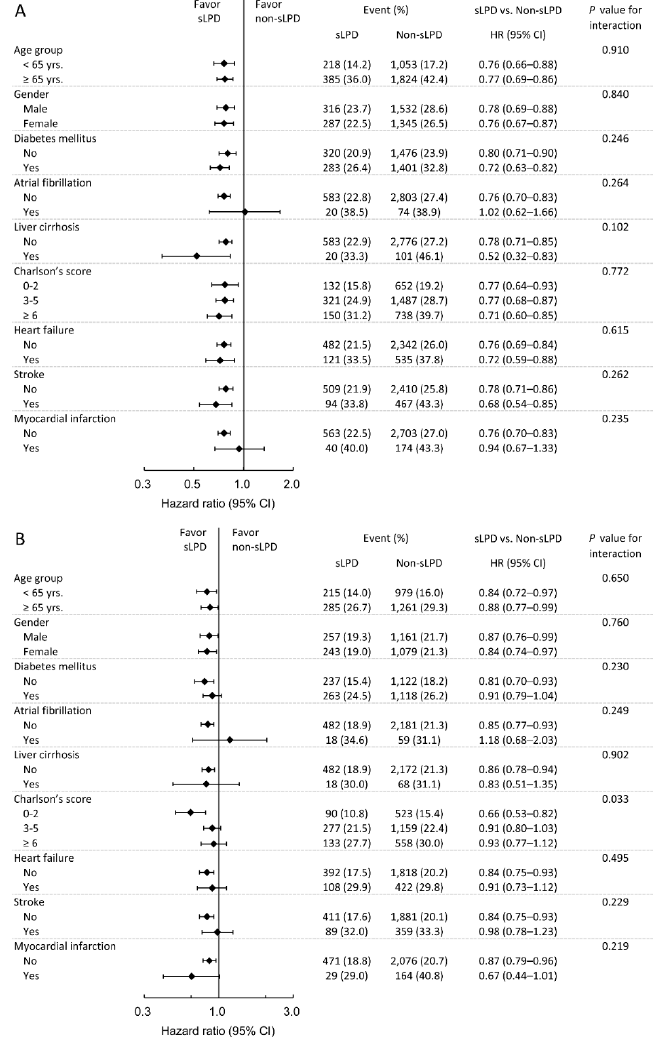
Figure 3. Prespecified subgroup analysis of all-cause mortality ( A ) and major cardiac and cerebrovascular events ( B ). HR: hazard ratio. events ( B ). HR: hazard